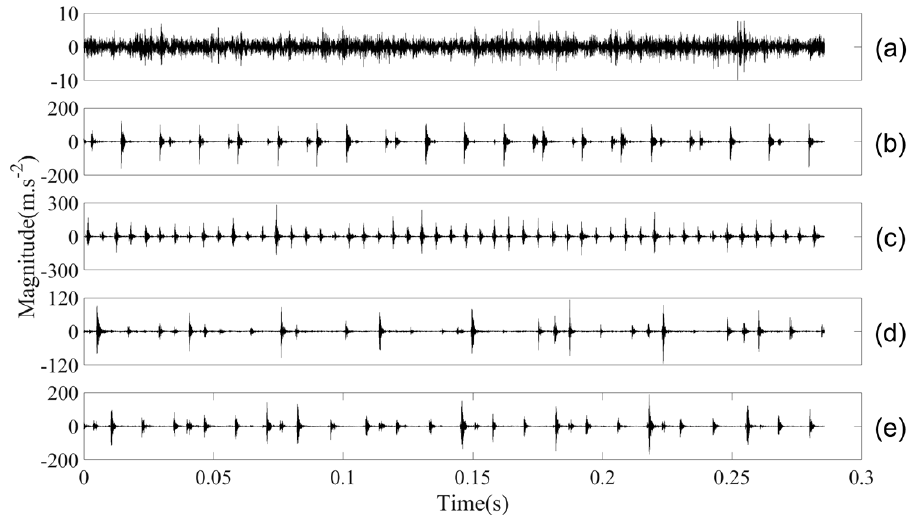
e n Figure 15. Skewness of the five types of roller-bearing vibration data. Figure 15. Skewness of the five types of roller-bearing vibration data. S k e w